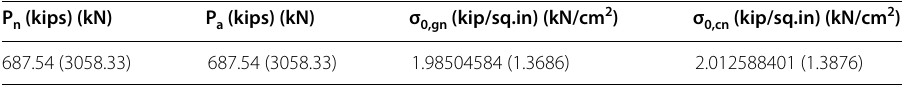
Table 4 Direct stresses for gross and core cross-sections P n (kips)